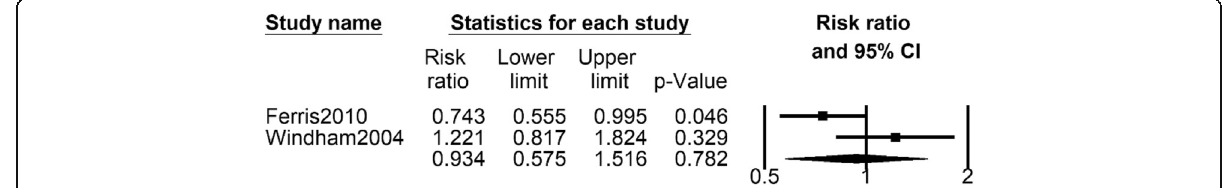
Fig. 5 Forest plot for the number of girls with early menarche between both PTS and ETS group with control